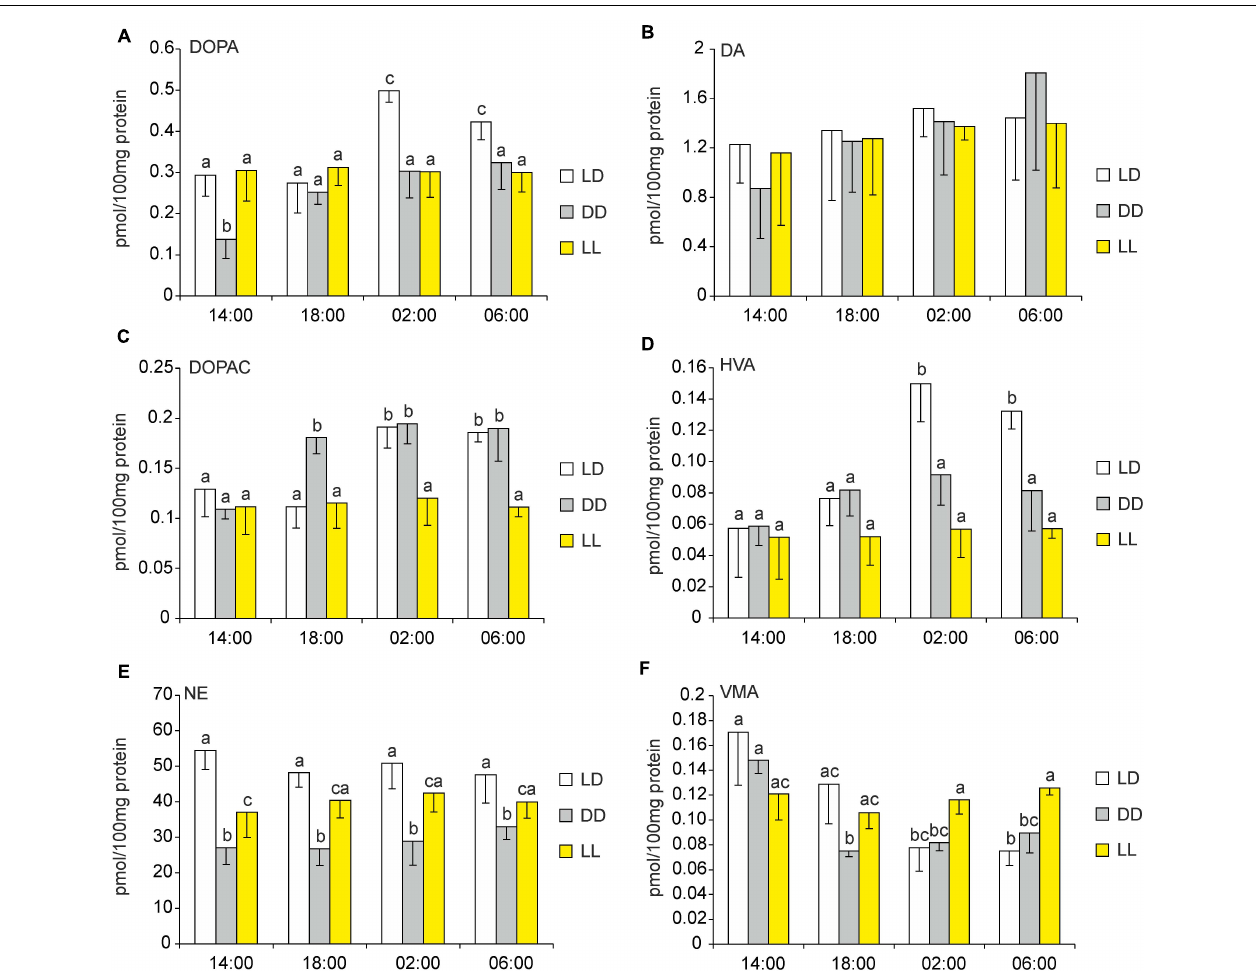
FIGURE 10 | (A–F) Effect of constant darkness and constant light on catecholamines and their metabolites in goose pineal organs. (A–F) Geese were kept in constant light or constant darkness for 10 days before 3,4-dihydroxyphenylalanine (DOPA), dopamine (DA), 3,4-dihydroxyphenylacetic acid (DOPAC), homovanillic acid (HVA), norepinephrine (NE), and vanillylmandelic acid (VMA) contents were measured. Figures show means and standard errors ( n = 4). Abbreviations and explanations as in Figure 9